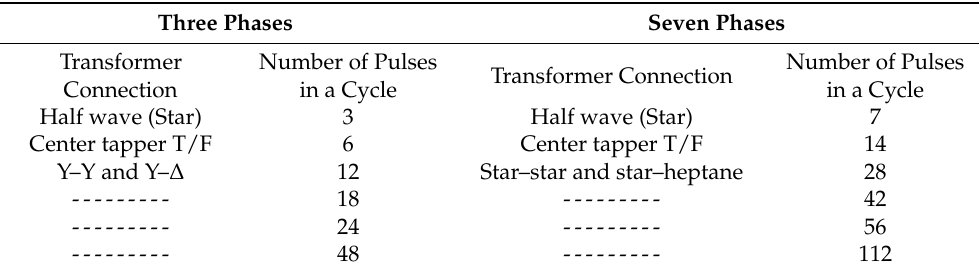
Table 6. Transformer rectifier unit (TRU) pulses three- and seven phases in a single cycle.